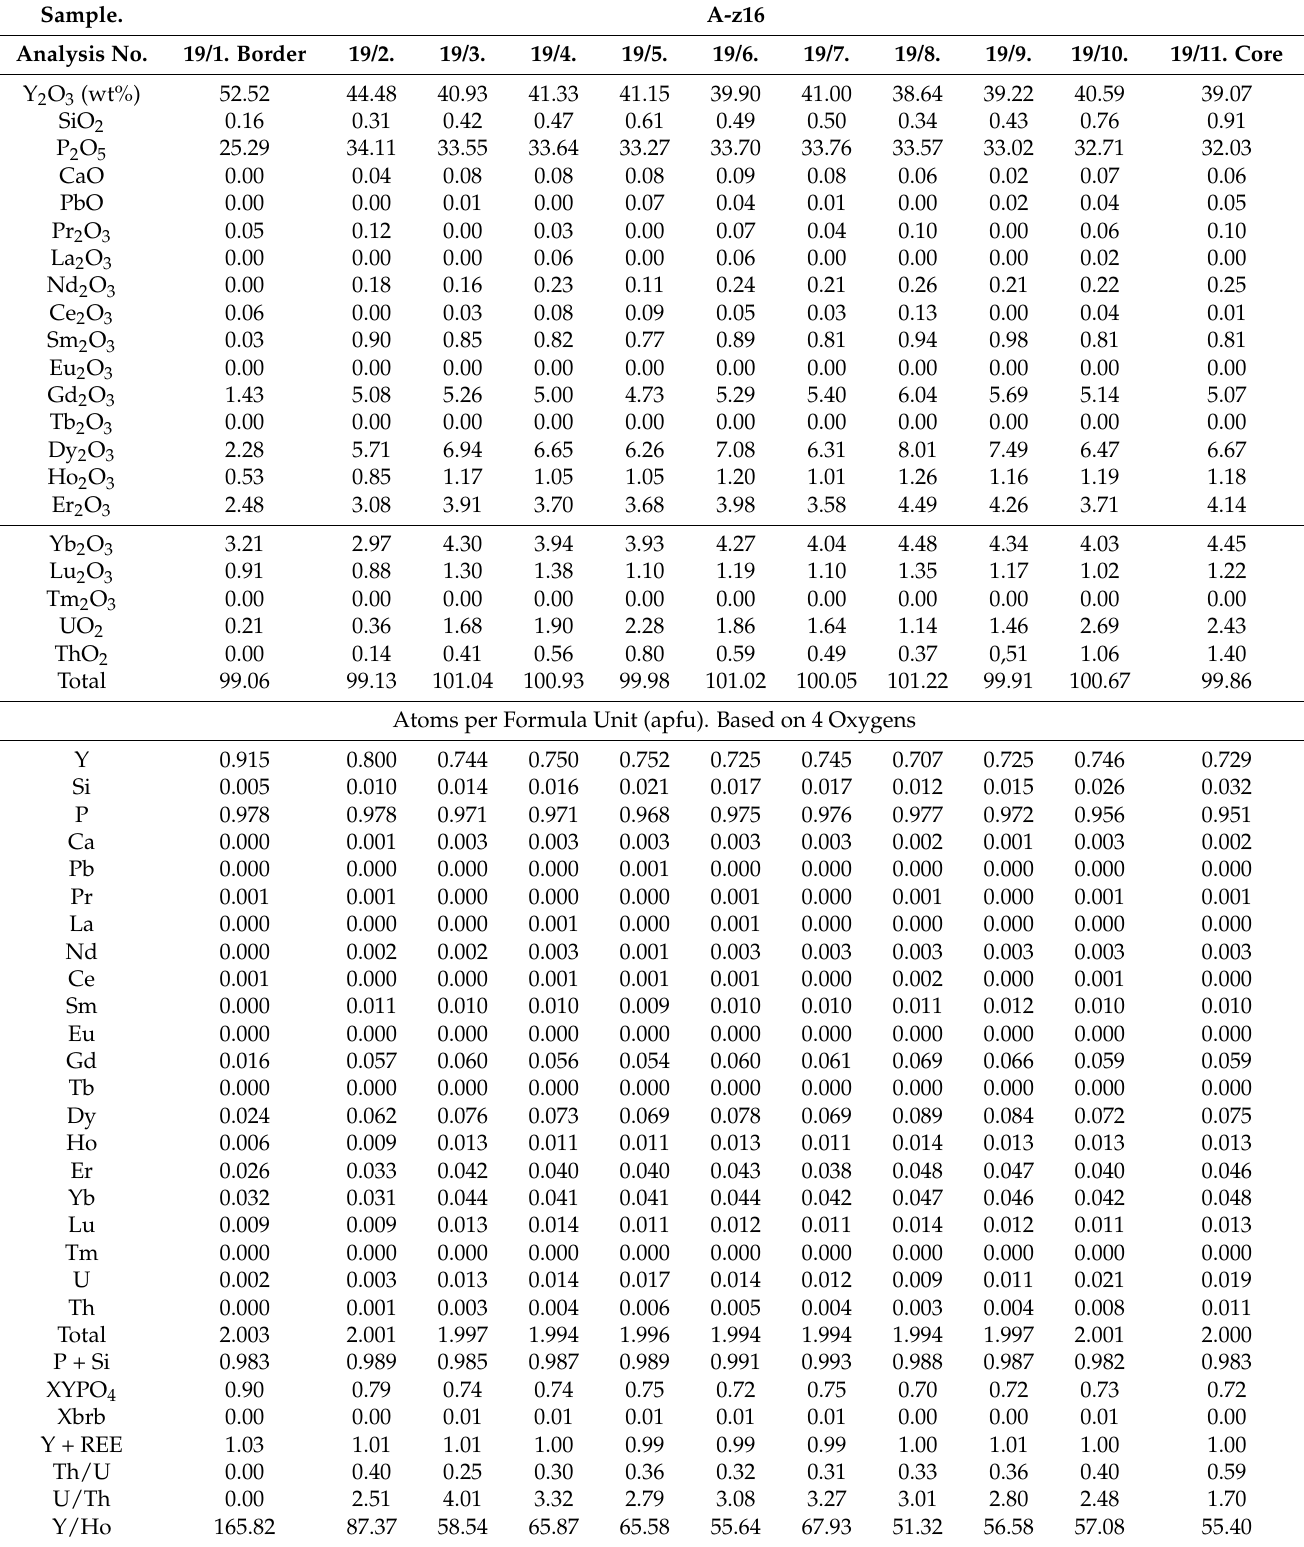
Table 3. Variability of zonal xenotime chemistry along the study profile. EMP